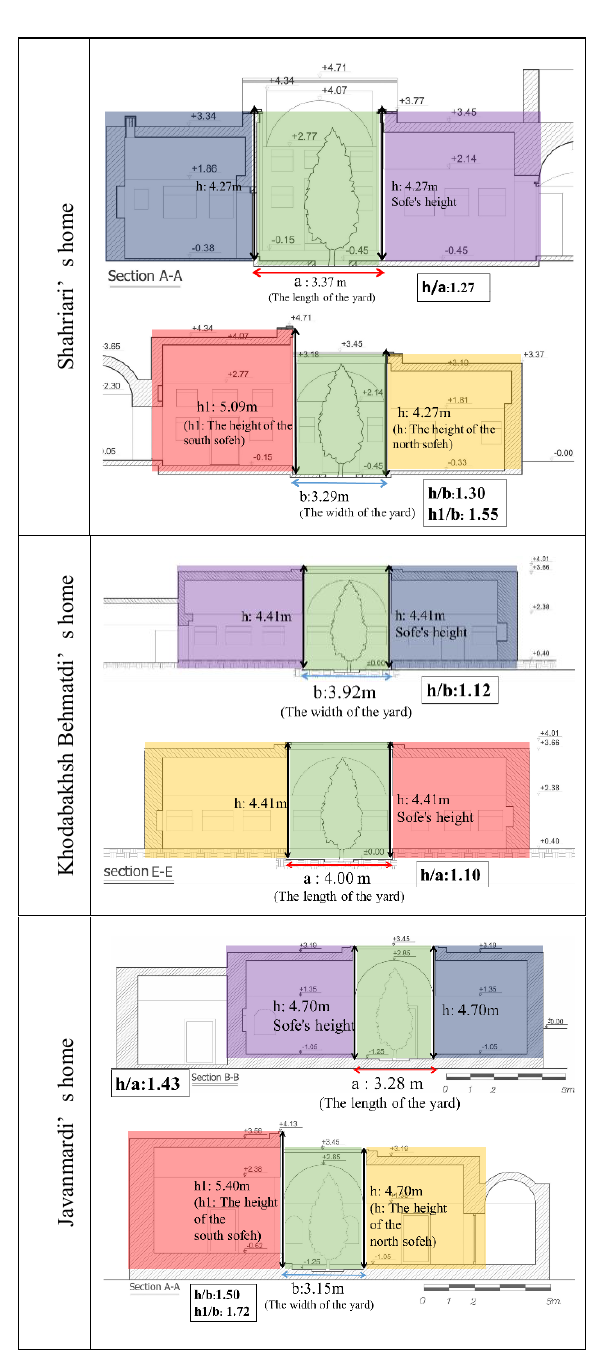
Table 2. The proportion between dimensions of central courtyard with the height of the sofe.